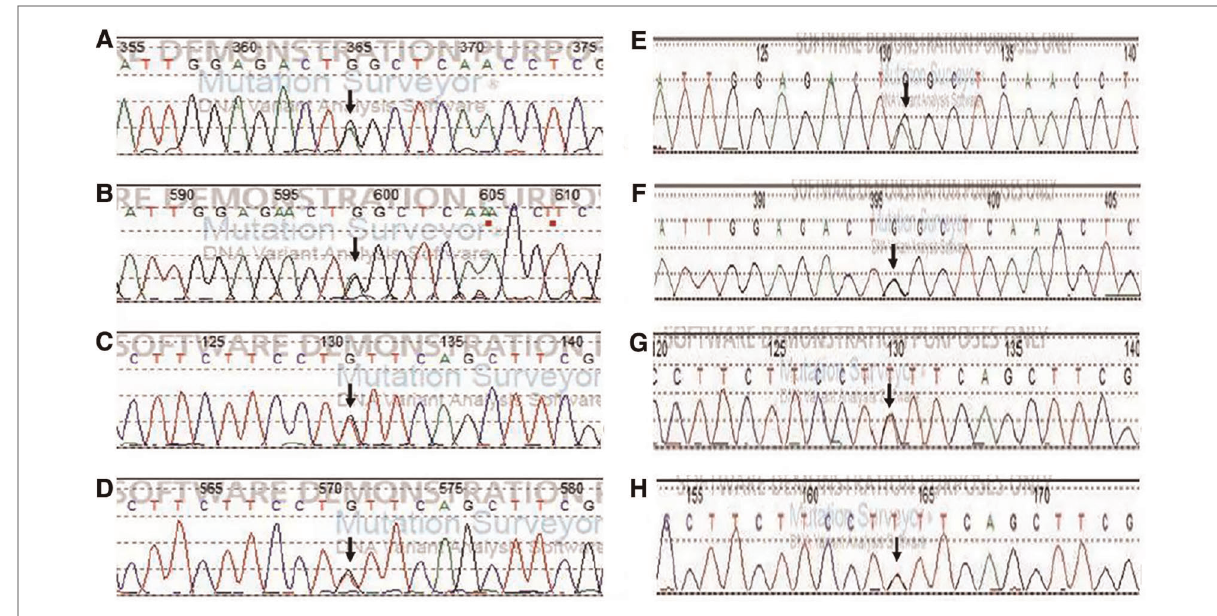
FIGURE 1 Sequencing results of the G6PC in the patient and his parents. Note: The mutation sites are indicated by arrows. ( A ) c.209G>A in exon1 by forward sequencing in the patient. ( B ) c.209G>A in exon1 by reverse sequencing in the patient. ( C ) c.648G>T in exon 5 by the forward sequencing in the patient. ( D ) c.648G>T in exon 5 by reverse sequencing in the patient. ( E,F ) c.209G>A in exon 1 from his father (by forward and reverse sequencing). ( G,H ) c.648G>/T in exon 5 from his mother (by forward and reverse